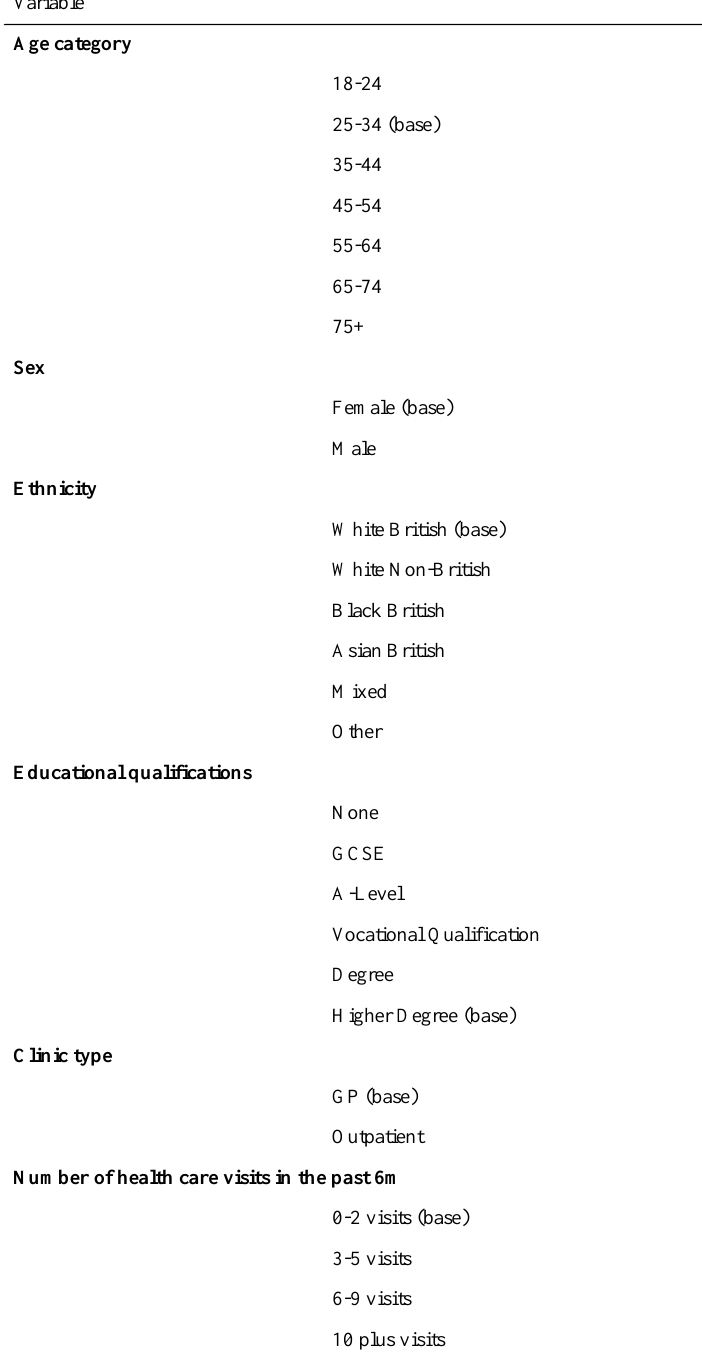
Table 1. Summary statistics of final analysis sample by sociodemographics, health, and health care use characteristics